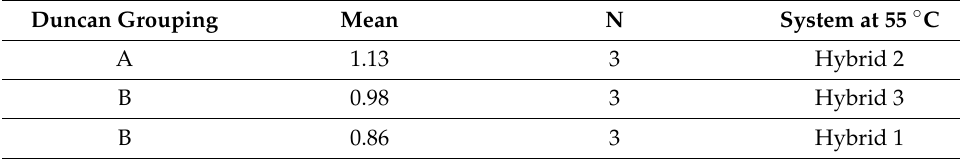
Table 9. Used fuel ratio of hybrid systems 1, 2, and 3.